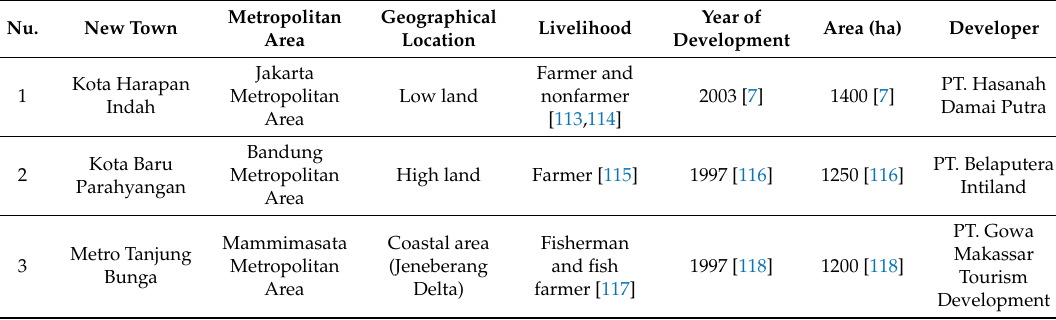
Table 1. Di ff erent characteristics of the three